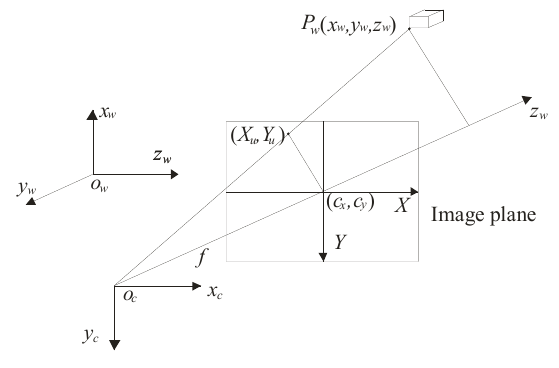
Figure 1. Geometry of the perspective projection